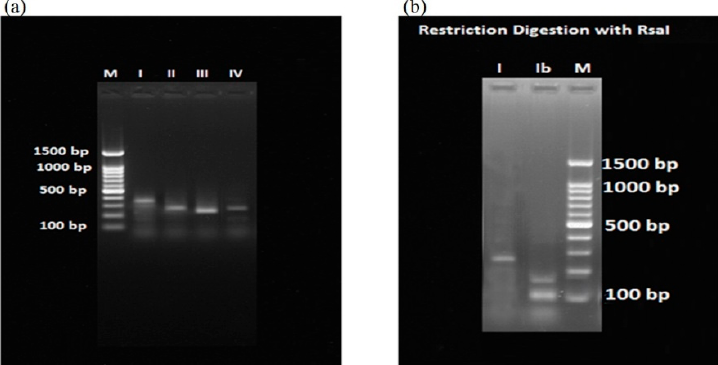
Figure 1. Agarose gel images showing the amplification of fimA genotypes: ( a ) amplification of fimA type I (392 bp), type II (257 bp), type III (247 bp), and type IV (251 bp); ( b ) restriction digestion with the RsaI enzyme yielded type I (271 bp) and type Ib (169 bp, 109 bp). Table 2. Frequency distribution of fimA genotypes in subjects detected positive for P. gingivalis in the chronic periodontitis and healthy groups.